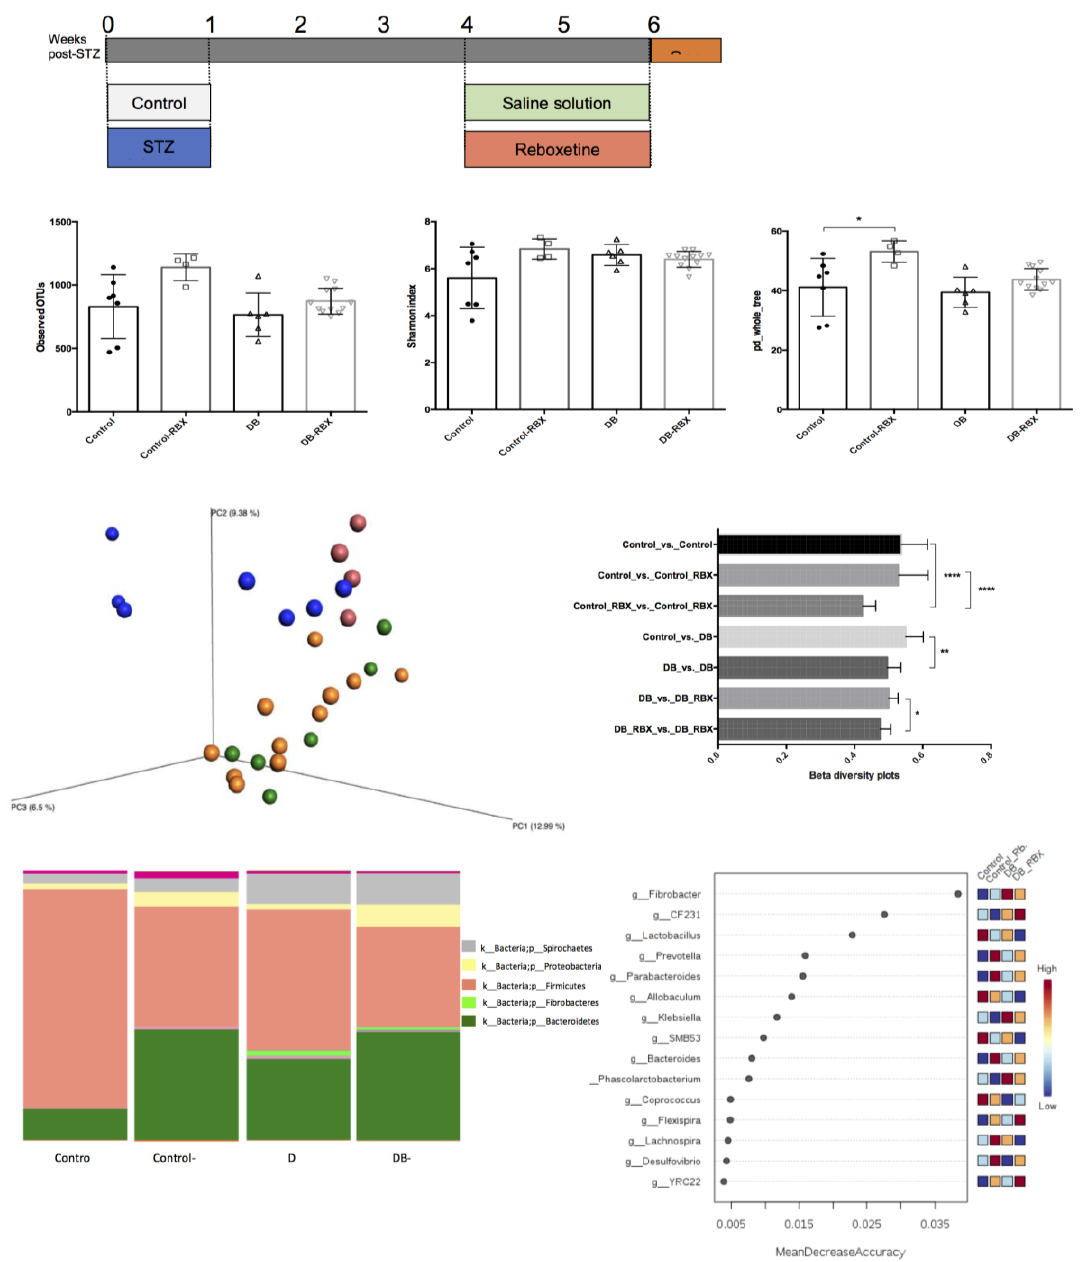
Figure 1. Effect of RBX on intestinal microbial community. ( A ) Study design: Either streptozotocin (STZ) or vehicle was introduced for 1 week. Reboxetine (RBX) was administered at week 4 post-STZ for 14 days. ( B ) Alpha diversity comparisons between the groups (observed OTUs, Shannon index, and phylogenetic diversity). ( C ) Unweighted UniFrac analysis between all groups ( p = 0.001) and beta diversity pilot distance comparisons within and between groups. ( D ) Relative taxa abundances between all groups at phylum level. ( E ) Random forest analysis of control and diabetic rats. Kruskal–Wallis test with Dunnett’s multiple comparisons test was used for statistical significance. * p < 0.05; ** p < 0.01; **** p < 0.0001.